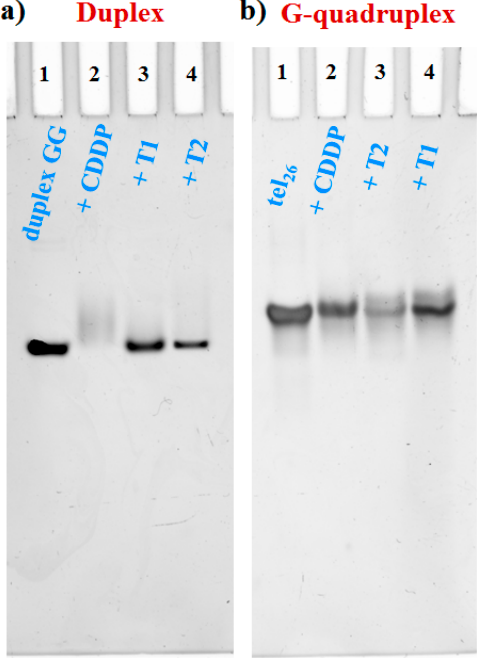
Figure 6. Representative 25% polyacrylamide gel electrophoresis (PAGE) under native conditions relative to the GG -duplex ( a ) and the G-quadruplex ( b ) DNA systems (2 μ M concentration), alone (lanes 1) or incubated for 48 h with 10 equiv. of T1 , T2 , and CDDP, in 100 mM KCl, 7 mM Na 2 HPO 4 /NaH 2 PO 4 , pH = 7.2. Gel was run at 80 V, at r.t. for 3.3 h in TBE 1X buffer.